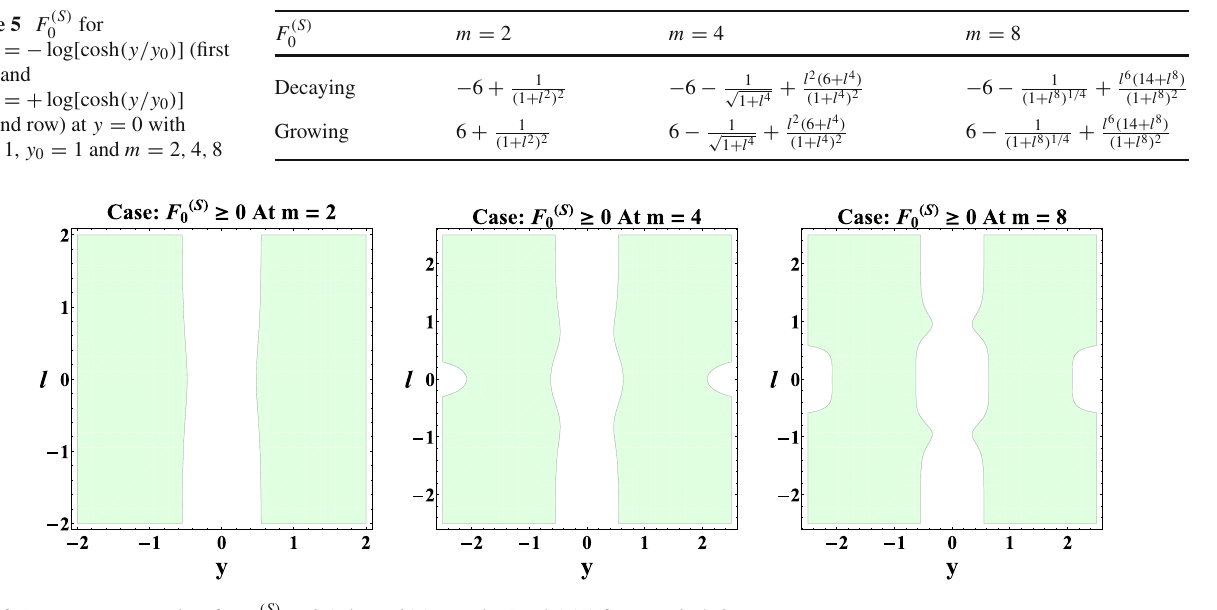
Fig. 7 Profile of F ( S ) of for 0 f ( y ) = − log [ cosh ( y ) ] (left plot) and f ( y ) = log [ cosh ( y ) ] (right plot) at | y | = 1 with b 0 = 1 and m = 2 (dotted curve), m = 4 (dashed curve) and m = 8 (continuous